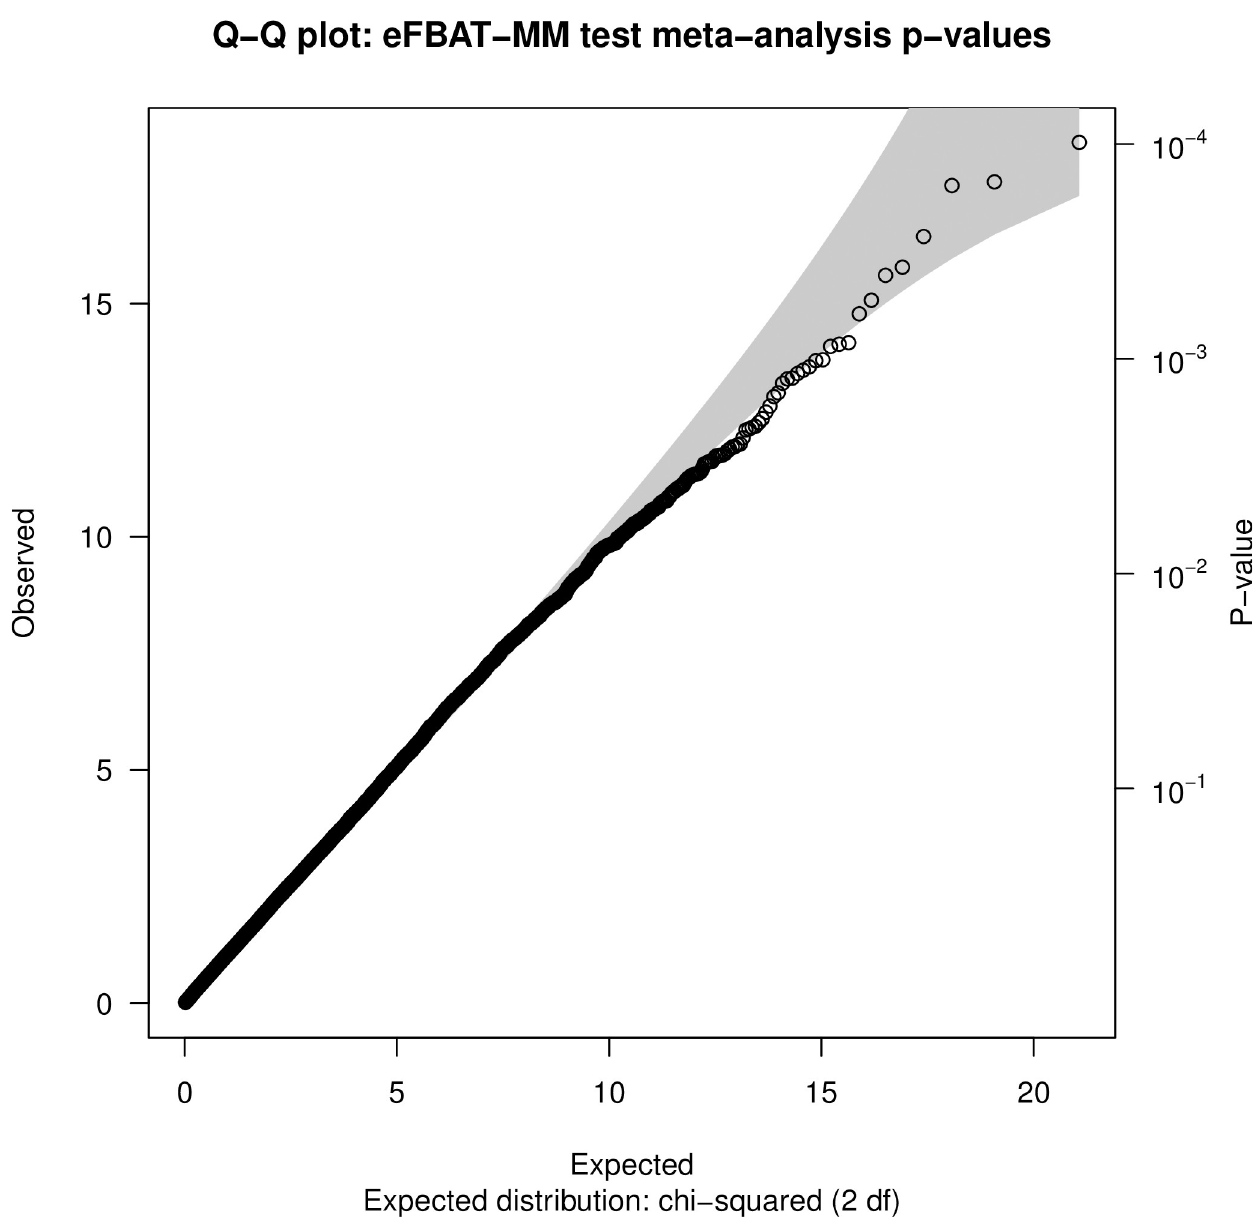
Fig 2. Quantile-quantile plot of eFBAT-MM test gene-level meta-analysis p-values.